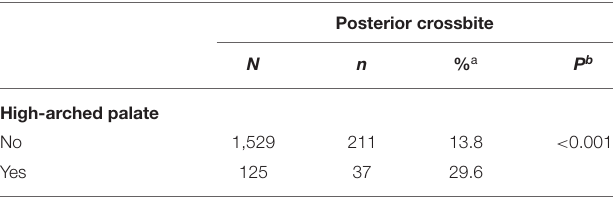
TABLE 3 | Association between high-arched palate and posterior crossbite at 5 ½ years.